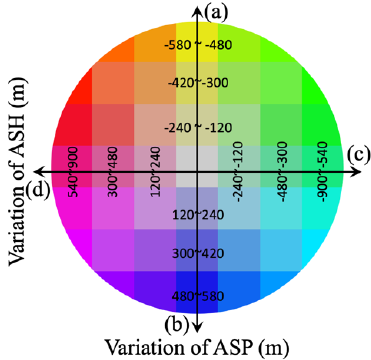
Figure 10 . 4 variation combinations of ASH and ASP. The direction of the arrows in (a), (b), (c), and (d) mean the variation described in Figures 6a, 6b, 9c, and 9d, respectively.